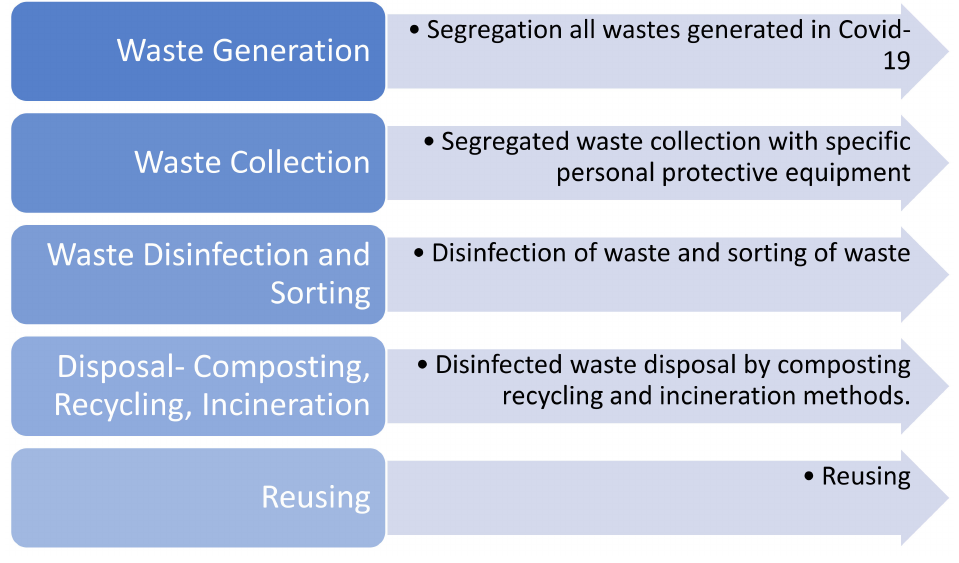
Figure 4. COVID-19 waste management